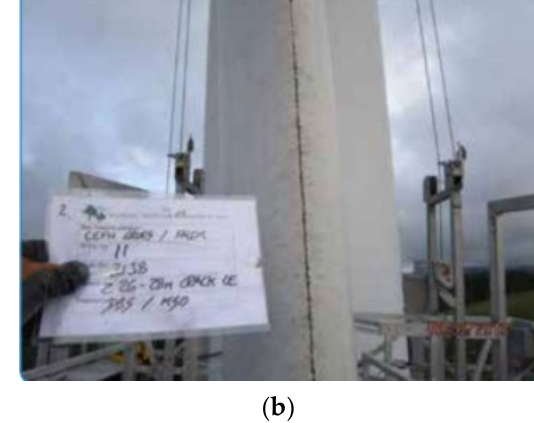
Figure 6. ( a ) Delamination, ( b ) Crack in the glue joint [29]